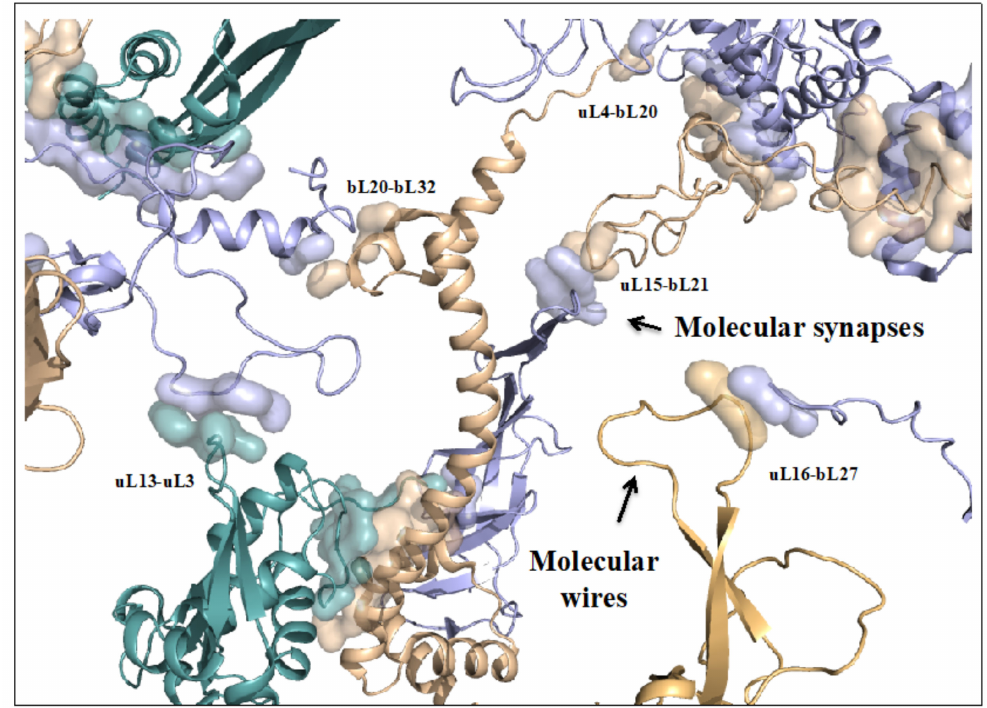
Figure 4. Molecular synapses and wires in the bacterial large subunit r-protein network. The tiny interfaces (the molecular synapses) between r-proteins are represented by surfaces. rRNA is not represented for